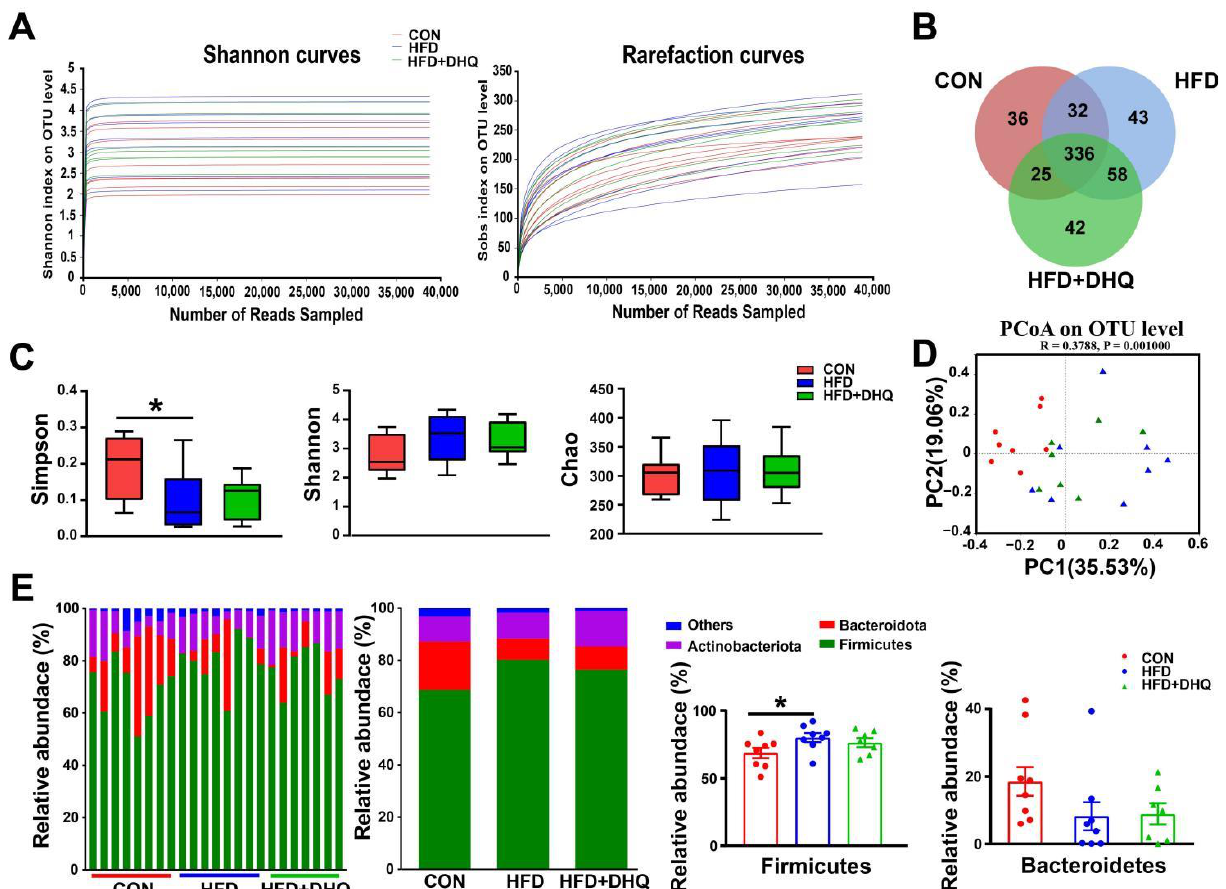
Figure 8. Effects of DHQ supplementation on fecal microbiota diversity and microbial composition at phylum level in mice. ( A ) Dilution curves; ( B ) Venn diagram; ( C ) α -diversity; ( D ) PCoA; and ( E ) microbial composition at phylum level. Data were expressed as the mean ± SEM. * p < 0.05 vs. CON group.